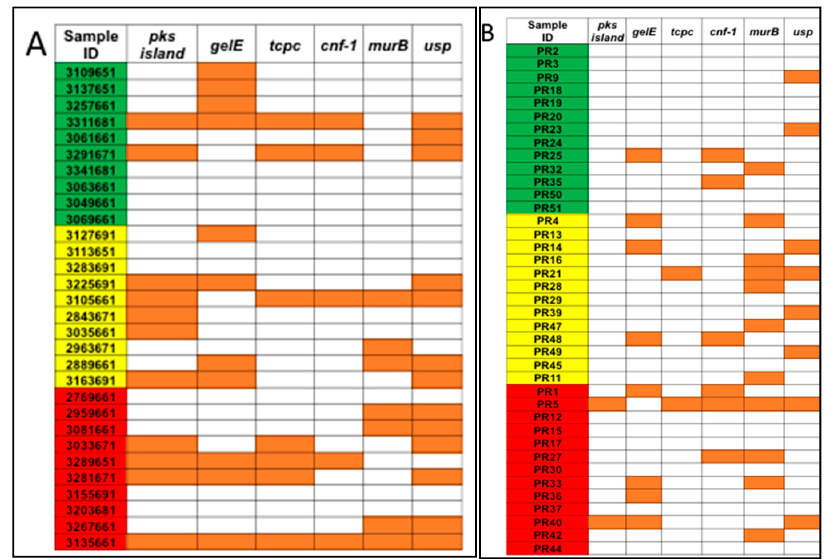
Figure 2. Pro-inflammatory and/or genotoxic bacterial genes were detected for ( A ) US samples from the Early Detection Research Network (EDRN) and ( B ) Puerto Rico samples from the University of Puerto Rico Comprehensive Cancer Center (UPR CCC). Samples were divided by diagnosis as controls (green), adenomas (yellow), and CRC (red). Orange squares represent samples that were positive for the gene.